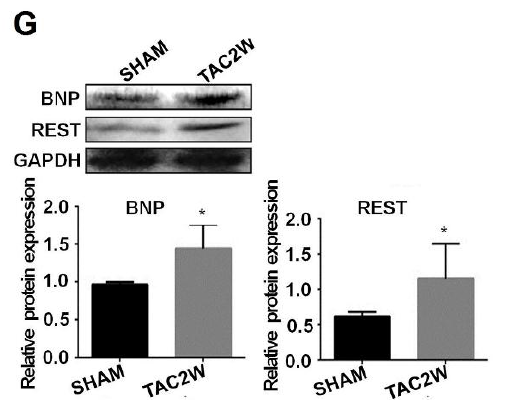
1 Figure 3. miR-218 targets the 3’-UTR of REST . ( A ) alignment of rat miR-218 sequence with the 3’-UTR of REST ; ( B ) luciferase assay showed that miR-218 targets the 3’-UTR of REST in H9C2 cells; ( C ) the mRNA levels of REST in H9C2 cells transfected by miR-218 mimic; NS: not significantly different; ( D ) the protein expression level of REST in H9C2 cells under different conditions; ( E ) the regulation of miR-218 on the protein level of REST in NRCMs stimulated by ISO; ( F ) the regulation of miR-218 inhibitor on the protein level of REST in NRCMs stimulated by ISO; and ( G ) the expression levels of BNP and REST in two-week TAC models ( n = 13) and sham mice ( n = 5). GAPDH was used as internal control (* p <